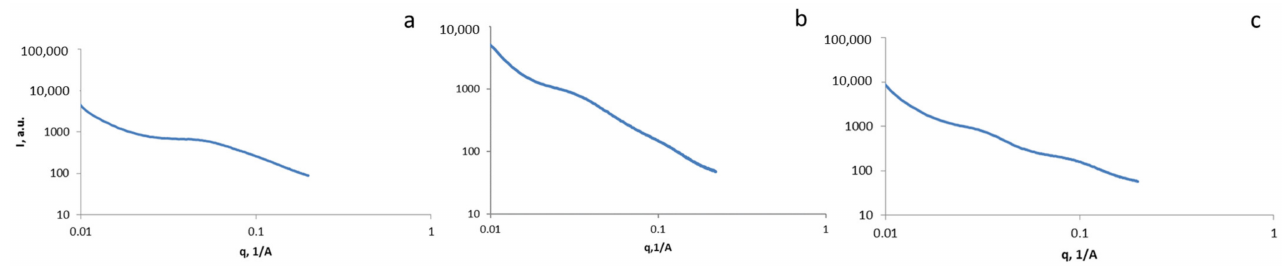
Figure 5. XR scattering curves in logarithmic scale for samples C ( a ), A2C1 ( b ), and A1C2 ( c